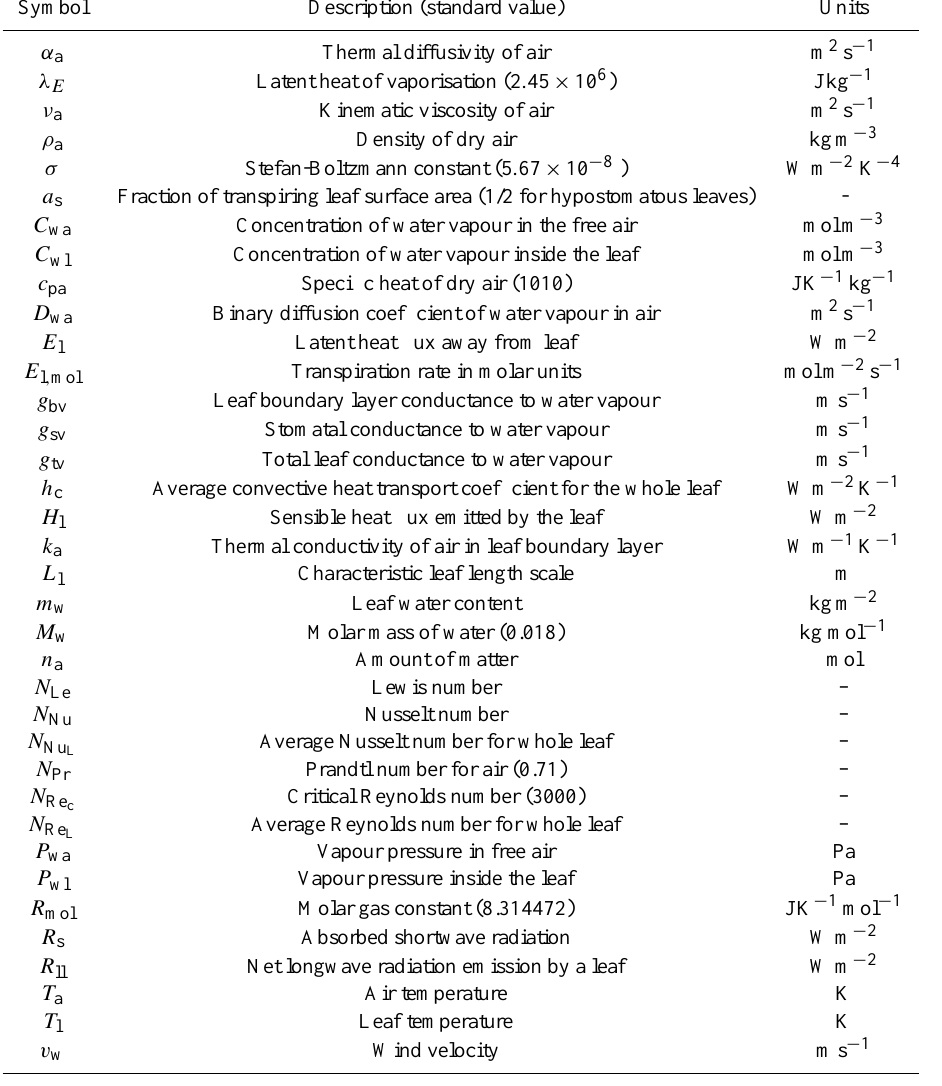
Table A1. Symbols, standard values and units used in this paper. All area-related variables are expressed per unit leaf area.